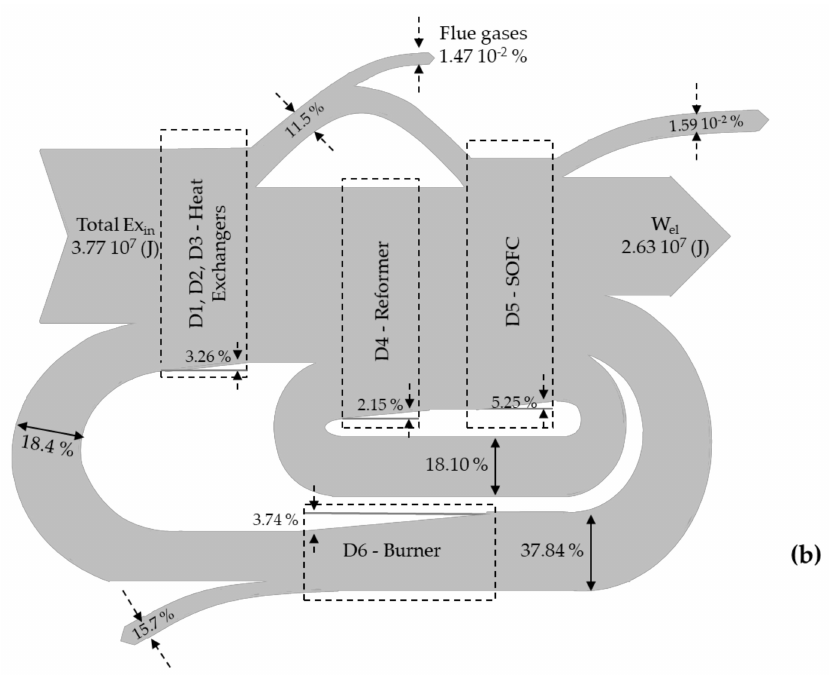
Figure 2. Sankey’s energy ( a ) and exergy ( b ) diagram for the optimized system ( λ = 2.5).